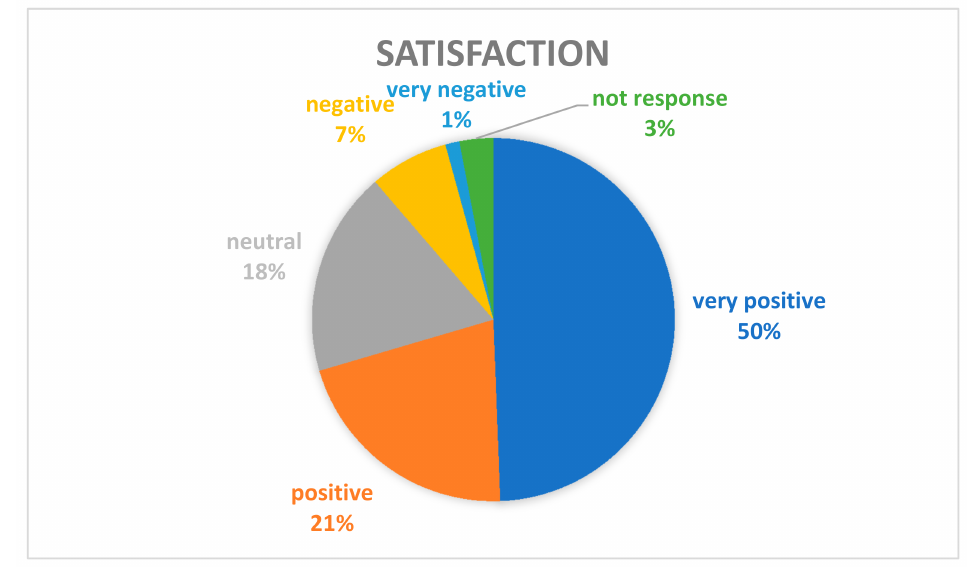
Figure 6. Graph of the average response to the satisfaction dimension